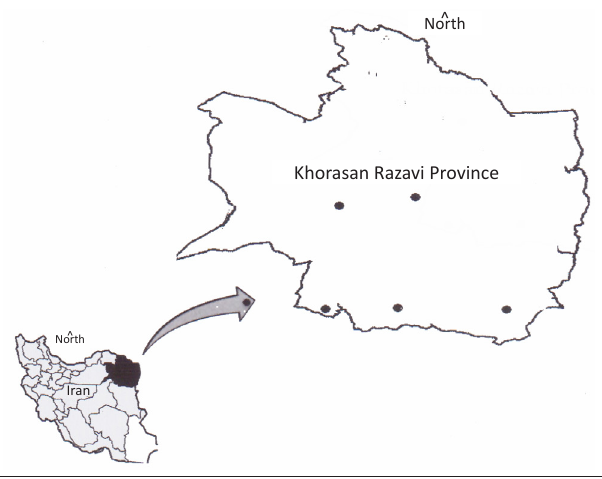
FIGURE 1: Locality where the fieldwork was carried out in Khorasan Razavi Province, Iran. TABLE 1: The sequences of primers used in semi-nested polymerase chain reaction. PCR product Nucleotide